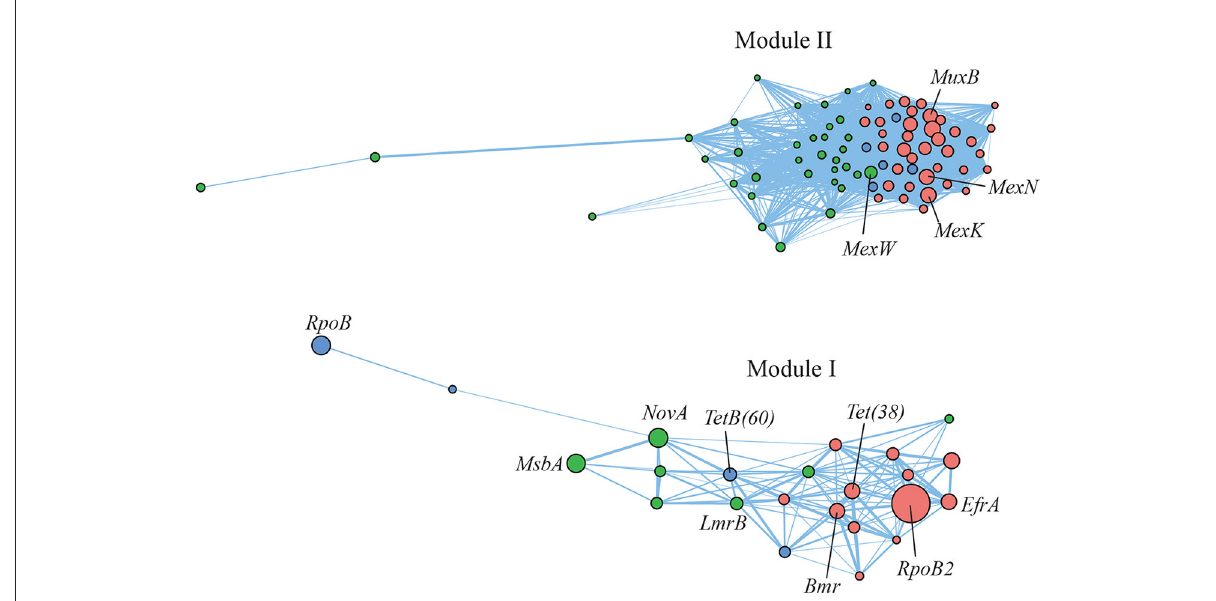
FIGURE5 Correlation network analysis of the gut antibiotic-resistant genes (ARGs) of Anser erythropus wintering at Shengjin (SJ) and Caizi (CZ) Lakes.